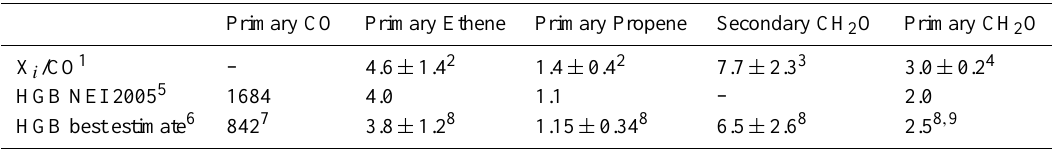
Table 3. Summary of emission fluxes of CO, ethene, propene and formaldehyde estimated for the HGB on-road vehicle fleet, given as 24-h averages. The indicated uncertainties are estimated 95% confidence limits.